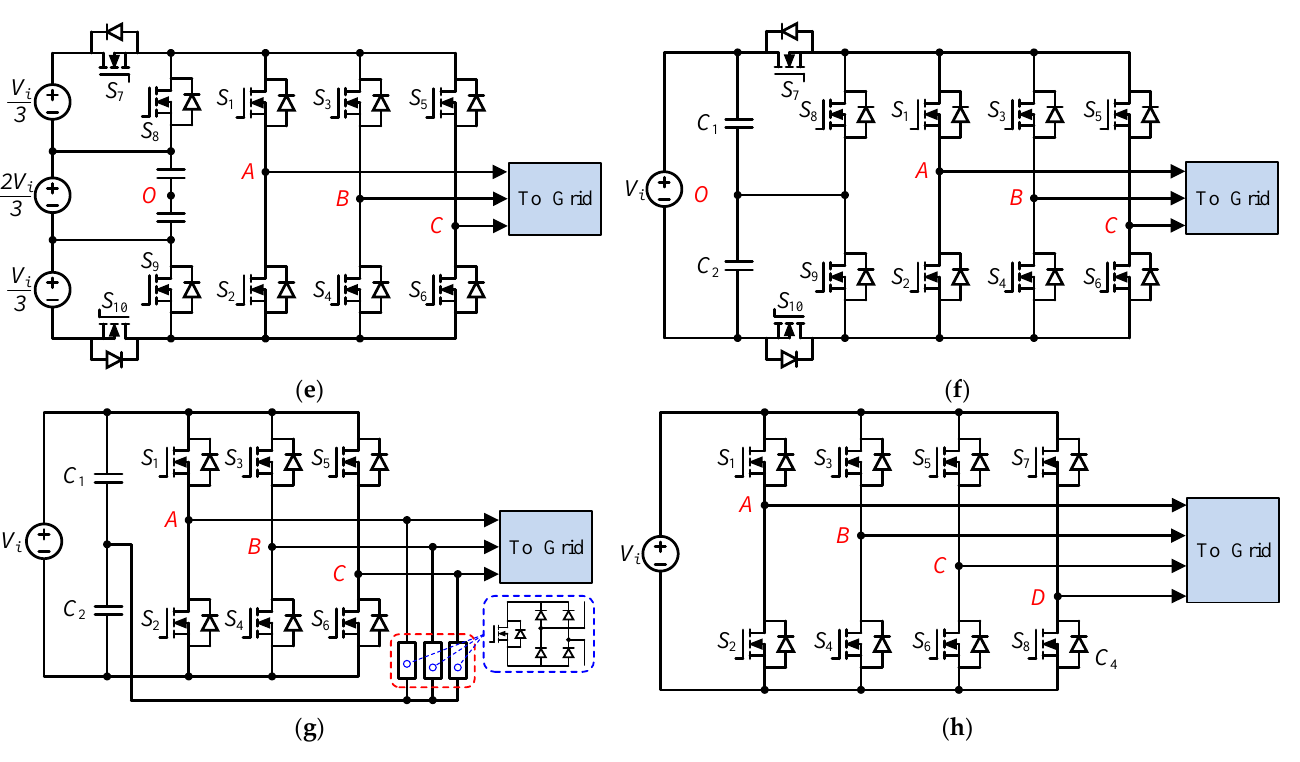
Figure 4. CMV reduction topologies. ( a ) H7 topology [42,43], ( b – d ) H8 topologies [44 – 47], ( e , f ) H10 topology [48,49], ( g ) ZVR topology [50], and ( h ) four-leg topology [51].